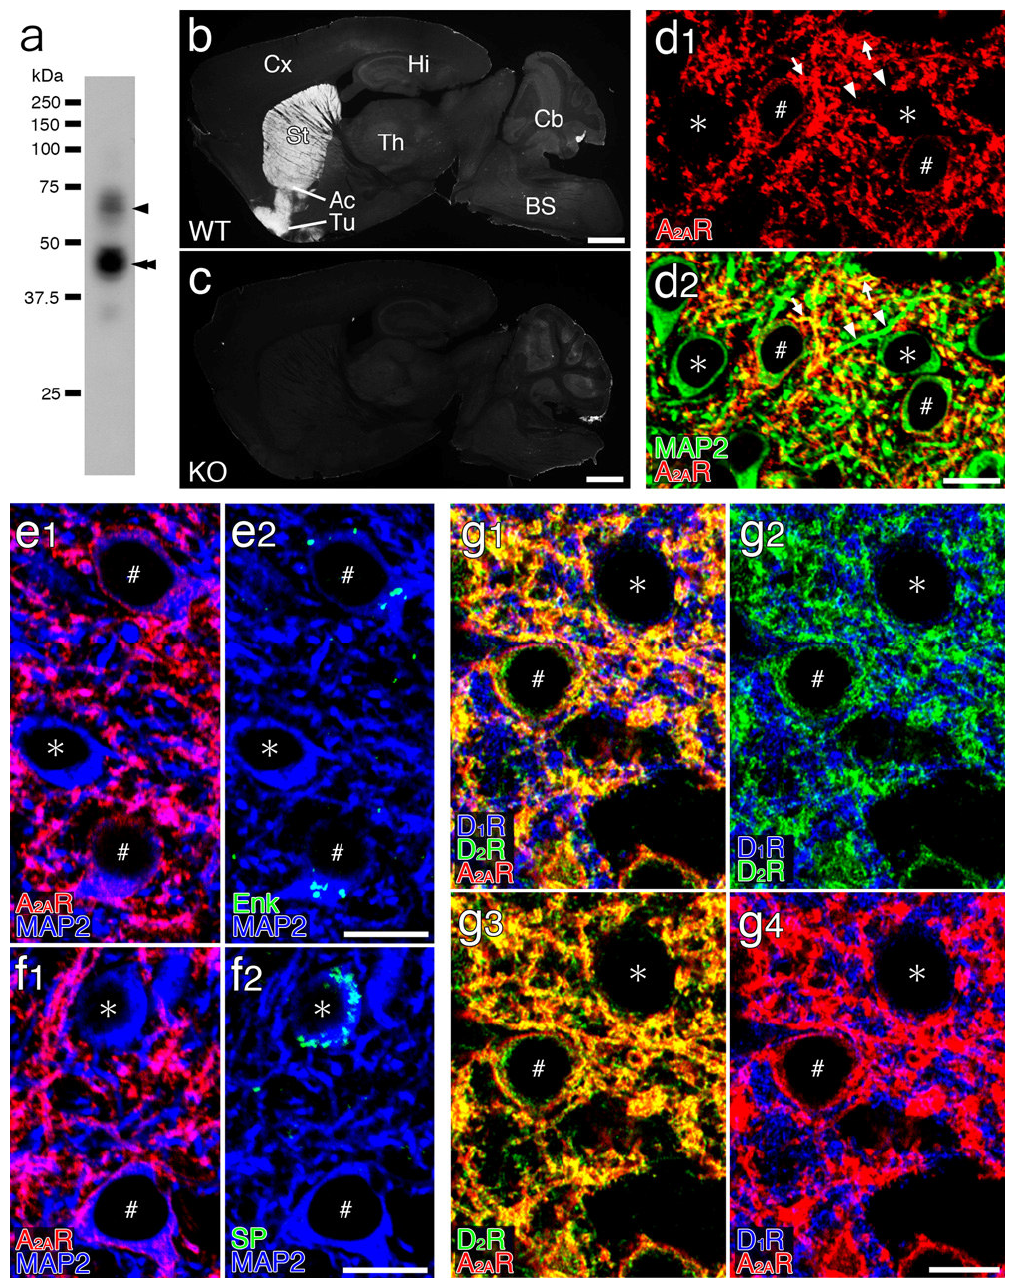
FIGURE 1. Characterization of anti–A 2A receptor antibody. (a) Immunoblot analysis with striatal protein sample showing that anti–A 2A receptor antibody recognizes major (double arrowhead) and minor (single arrowhead) protein bands at about 44 and 62 kDa, respectively. (b,c) Single immunofluorescence of parasagittal brain sections showing an exclusive immunoreactivity in the striatum (St), nucleus accumbens (Ac), and olfactory tubercule (Tu) of the wild-type mice (WT), but not A 2A receptor knockout mice (KO); Cx, cortex; Hi, hippocampus; Th, thalamus; Cb, cerebellum; BS, brainstem. (d) Double immunofluorescence for A 2A receptor (A 2A R, red) and MAP2 (green) in the striatum showing a dense immunoreactivity for A 2A receptor on the surface of some MAP2-labeled somata (#) and dendrites (arrows); the remaining MAP2-labeled somata (*) and dendrites (arrowheads) did not express A 2A receptors. (e,f) Triple immunofluorescence for A 2A receptor (A 2A R, red), MAP2 (blue), and enkephalin (Enk, green) or substance P (SP, green) in the striatum showing a selective expression of A 2A receptors in Enk-positive medium spiny neurons (#). A 2A receptor is not detected in SP-positive medium spiny neurons (*). (g) Triple immunofluorescence for A 2A R (A 2A R, red), D 1 receptor (D 1 R, blue), and D 2 receptor (D 2 R, green) in the striatum showing a preferential distribution of A 2A in D 2 receptor–positive medium spiny neurons (#), but not in D 1 receptor–positive medium spiny neurons (*). Scale bars: (b,c) 1 mm; (d–g) , 10 µ